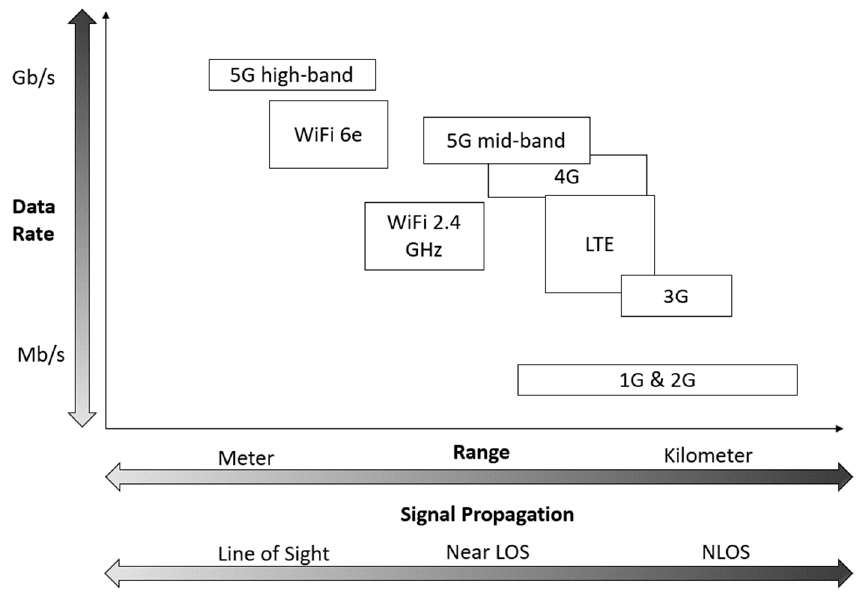
Figure 7. Generalized and simplified visualisation of the Wi ‐ Fi, 5G and other cellular technologies.